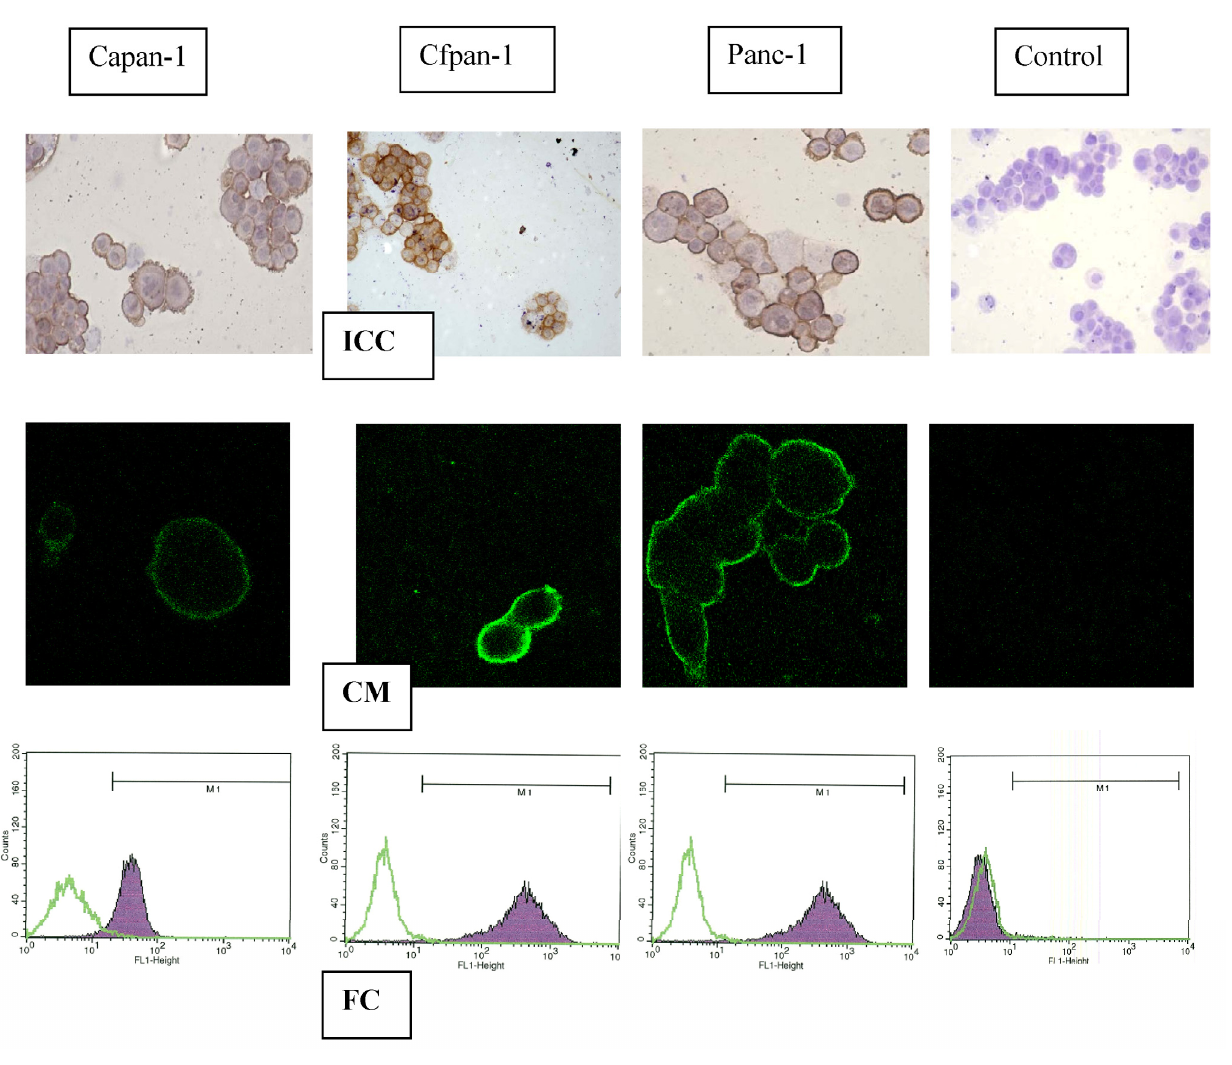
Figure 1. Flow cytometry (FC), confocal microscopy (CM) and immuno-cytochemistry